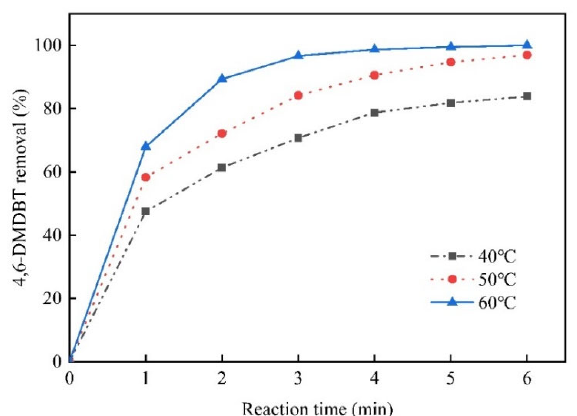
Figure 7. Effect of reaction time on DBT, BT, and 4,6-DMDBT desulfurization. Reaction conditions for DBT desulfurization: m (catalyst)/ m (fuel oil) = 0.018%, v (H 2 O 2 )/ v (fuel oil) = 0.30%, T = 40 ◦ C, 50 ◦ C, and 60 ◦ C. Reaction conditions for BT desulfurization: m (catalyst)/ m (fuel oil) = 0.018%, v (H 2 O 2 )/ v (fuel oil) = 0.30%, T = 40 ◦ C, 50 ◦ C, and 60 ◦ C. Reaction conditions for 4,6-DMDBT desulfurization: m (catalyst)/ m (fuel oil)=0.018%, v (H 2 O 2 )/ v (fuel oil) = 0.30%, T = 40 ◦ C, 50 ◦ C, and 60 ◦ C.